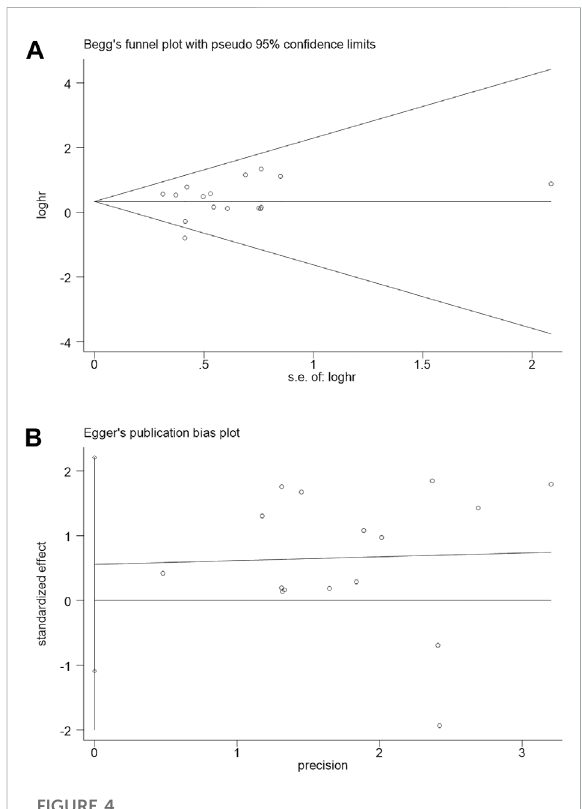
FIGURE 4 Begg ’ s publication bias plots (A) and Egger funnel regression test (B) of overall